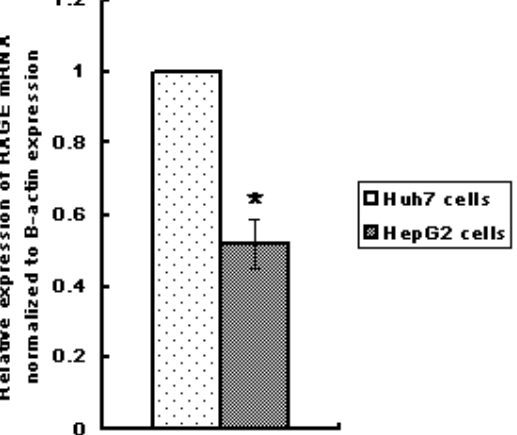
Figure 2. Relative expression of RAGE mRNA (normalized to β-actin expression) by HepG2 cells ( vs. Huh7 cells) analyzed by qRT-PCR; ( * p < 0.01). Three independent measurements were made and averaged.